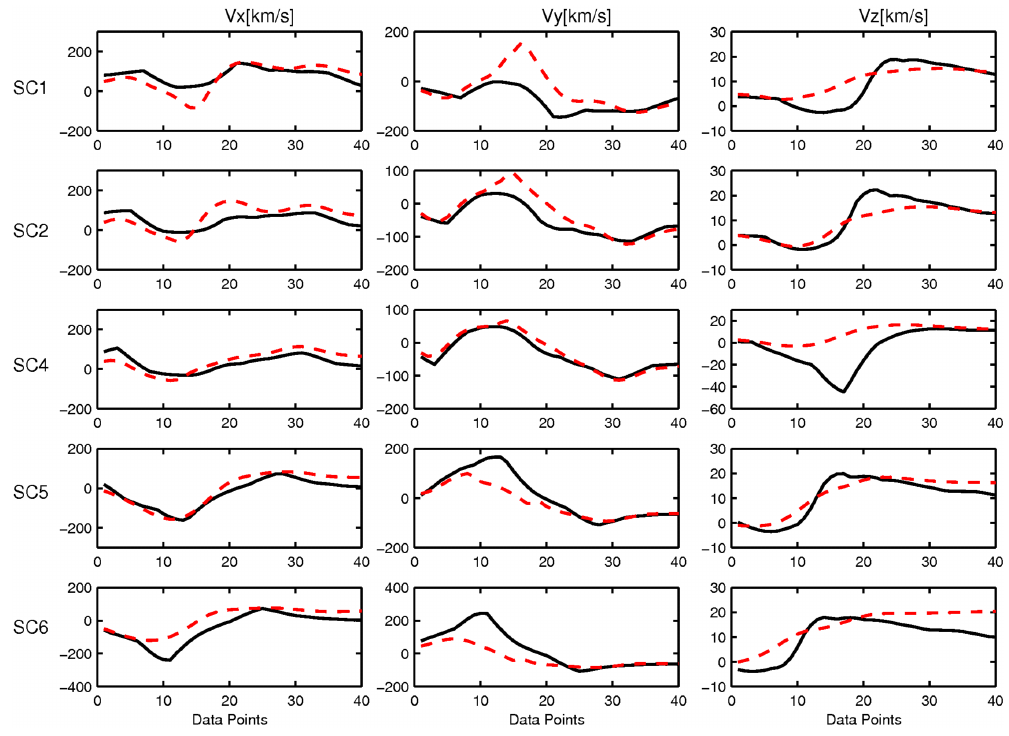
Figure 7. Snapshot plots of the predicted plasma velocities (red dashed lines) from the reconstruction map based on spacecraft 3 and the corresponding velocities (black lines) taken by the other spacecraft directly from the simulation. are less well predicted, with cc = 0.961 and cc = 0.927,